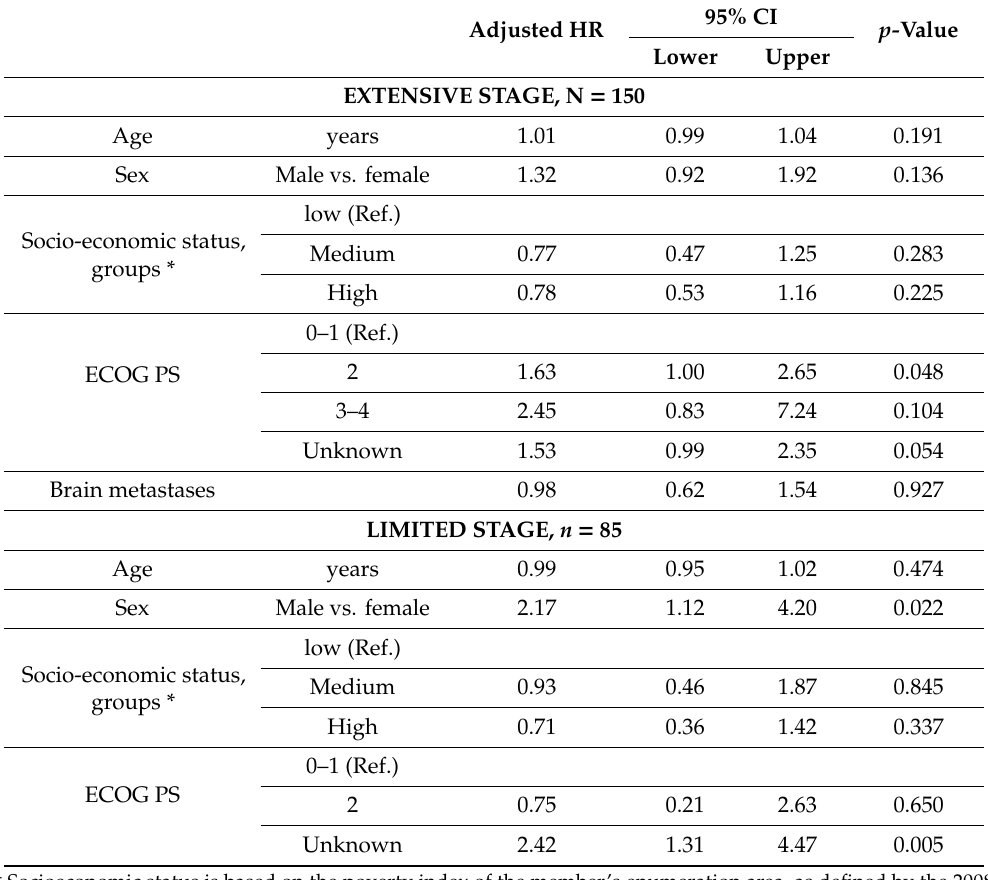
Table 3. Multivariable model for factors associated with survival from L1 treatment initiation for the study cohort (N =